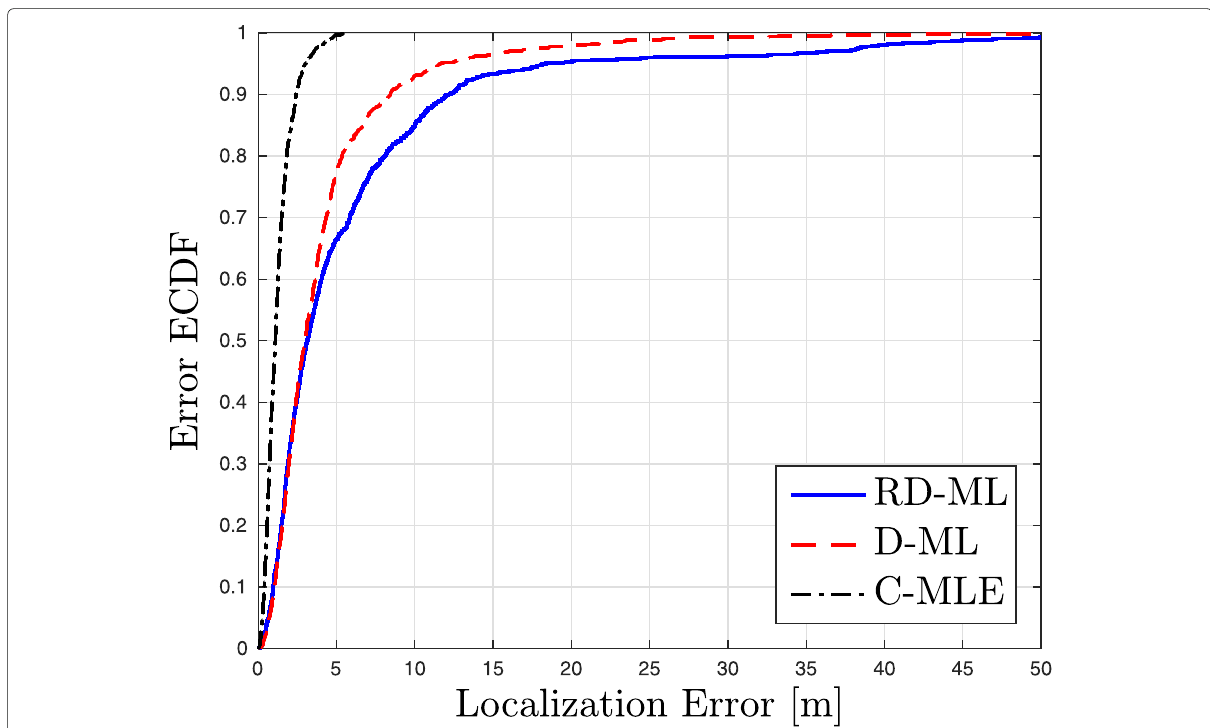
Fig. 5 All NLoS links with white Gaussian noise. Fully connected networks, N a = 11, N u =